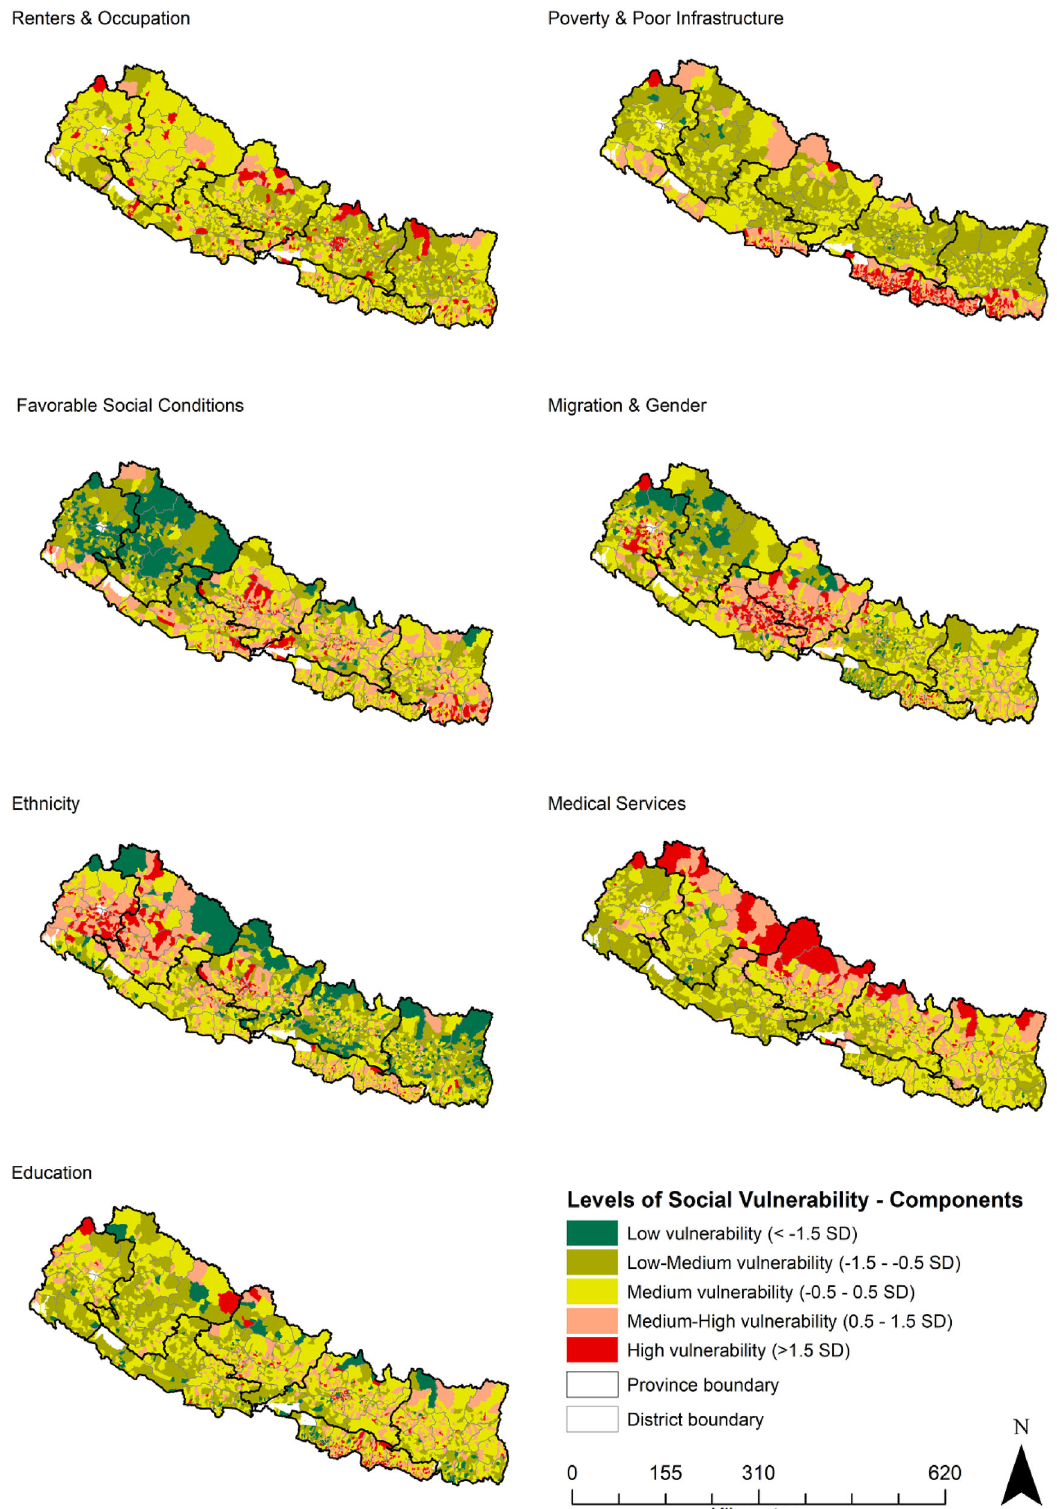
Fig. 3 Geographic distribution of principal component values of the modified Social Vulnerability Index in the seven provinces of